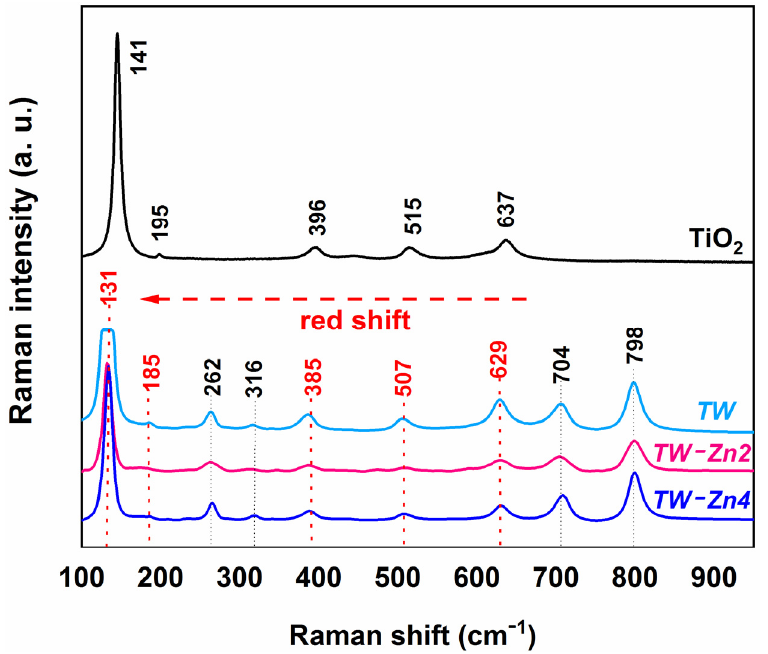
Figure 5. Raman spectra of anatase TiO 2 , TW and TW − Zn sintered MOHN (varying Figure 5 . Raman spectra of anatase TiO (cid:2870) , 𝑇𝑊 and 𝑇𝑊 − 𝑍𝑛 sintered 𝑀𝑂𝐻𝑁 (varying dopant concentrations). dopant The red shift phenomenon of TiO (cid:2870) vibrational bands is attributed to distortions and confinement of phonons in its crystalline lattice, promoted by the introduction of impuri- ties in the atomic structure of the material [29]. In fact, the combined analysis of the XRD and Raman results confirmed that Zn (cid:2870)(cid:2878) ions occupied the available sites of Ti atoms in the anatase crystal lattice.